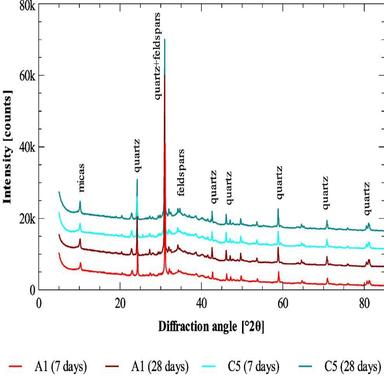
XRD diffractograms of A1 and C5 mixtures after 7 and 28 days.